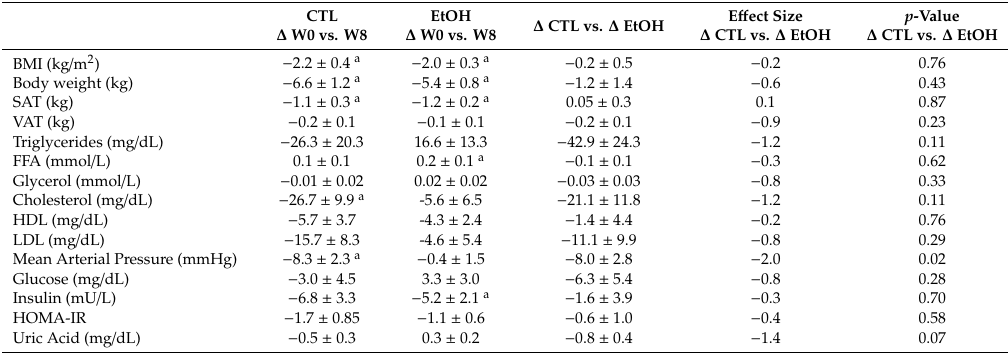
Table 1. Baseline, treatment, and changes in the clinical and metabolic characteristics of participants in the ethanol-free control (CTL) and the group that consumed 35 g ethanol daily for eight weeks (EtOH). CTL EtOH E ff ect Size ∆ CTL vs. ∆ ∆ W0 vs. W8 ∆ W0 vs. W8 ∆ CTL vs. ∆ EtOH